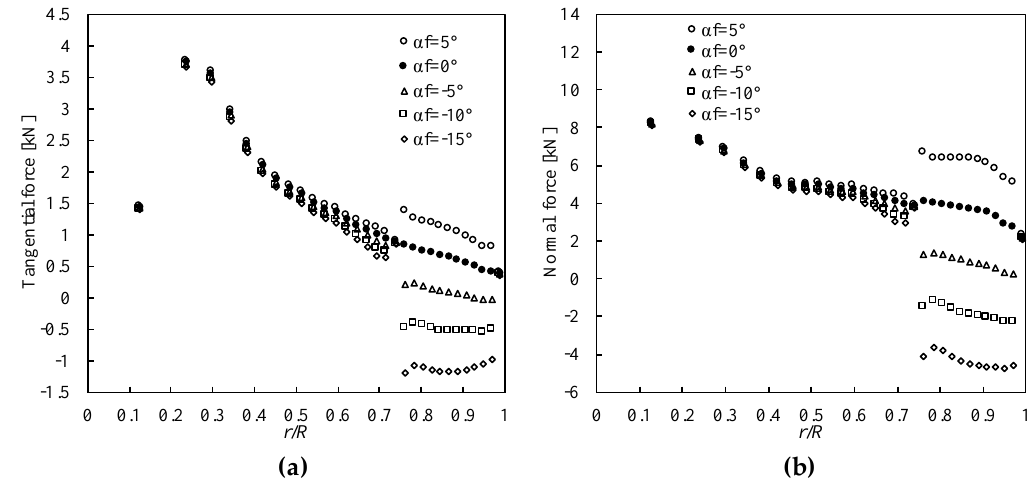
Figure 8. Aerodynamic force distribution of the blade control points for U = 16 m/s. ( a ) Tangential